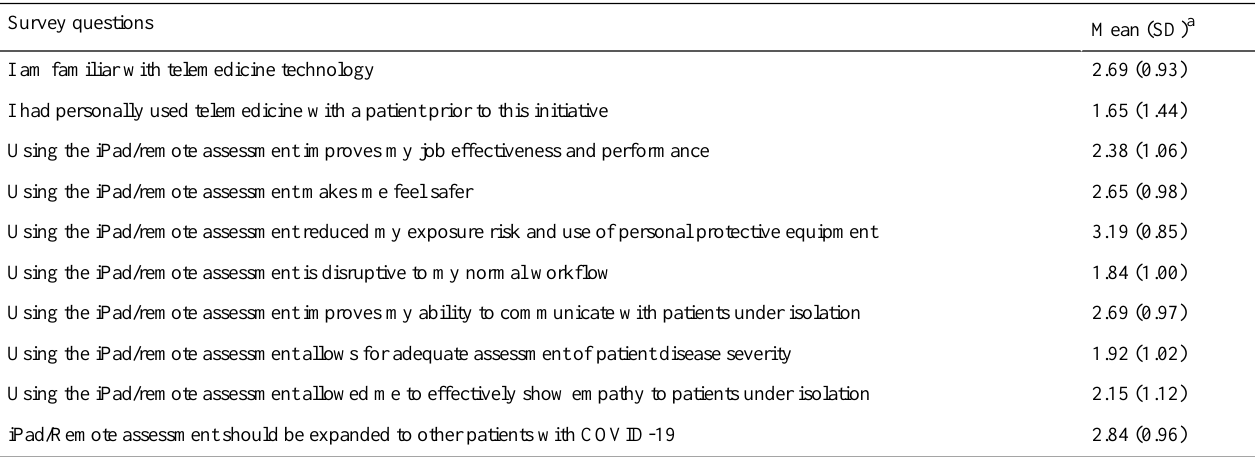
Table 4. Provider satisfaction: means and distribution of surveys to health care workers caring for patients with